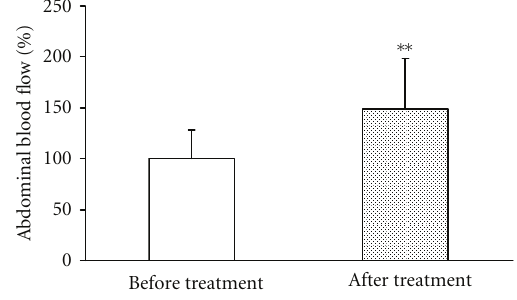
Figure 4: The relative abdominal blood flows before and after treatment. Expression values are the mean and standard deviation, and the di ff erence between groups was tested using Wilcoxon Signed-Rank Test. Double asterisk mean that this group was highly significantly di ff erent from control group ( P < 0 .